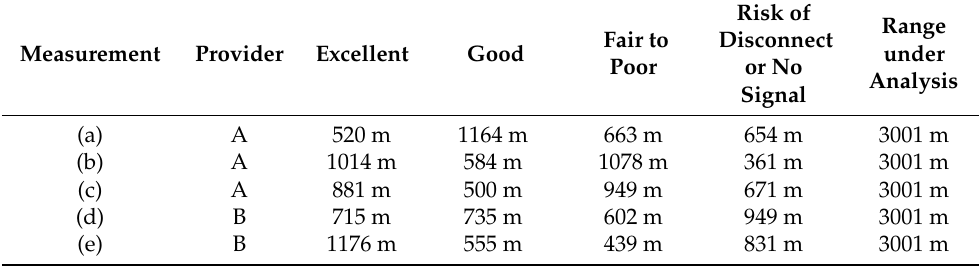
Table 6. Provider based assessment